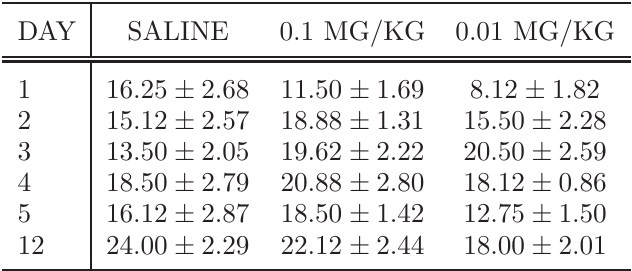
Table 6 Effects of CGP76291 on active avoidance